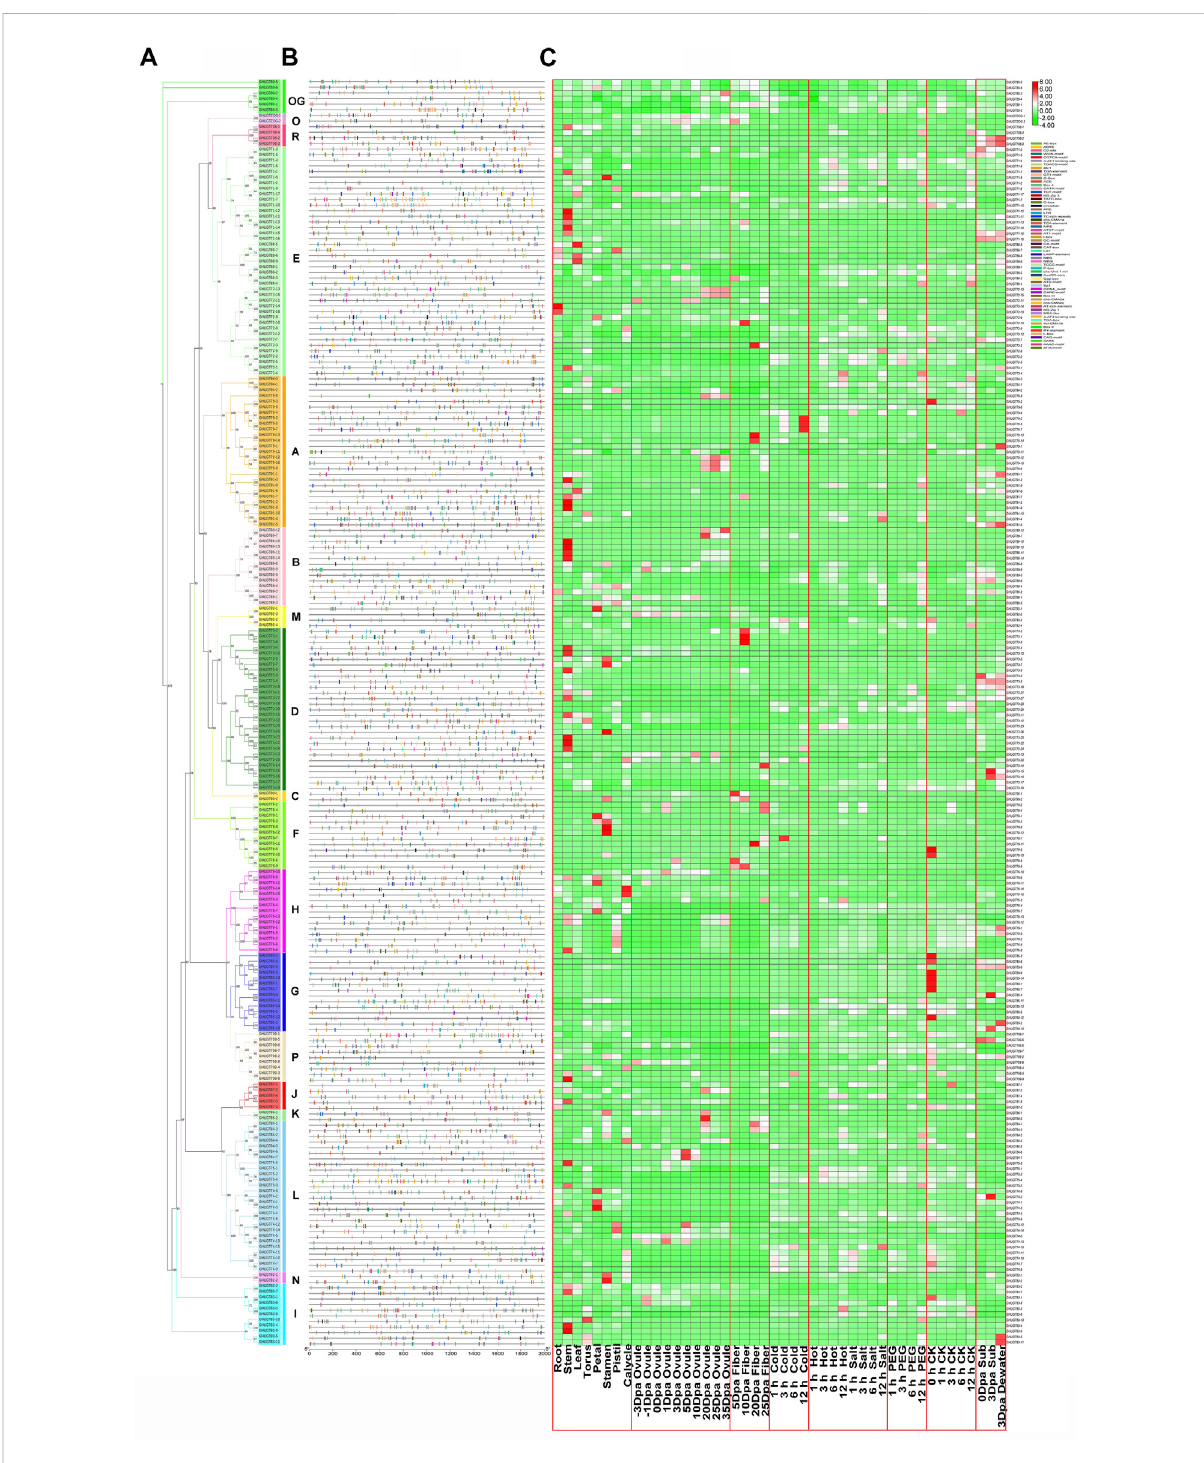
FIGURE 10 Promotersanddifferentiallyexpressedgeneanalysisofthe GHUGT family. (A) Phylogenetic treeof GHUGTs . (B) Cis-elements inthepromoters of GHUGTs . (C) Differentiallyexpressedgenesof GHUGTs undercold,hot,salt,PEGandsubmergencestressandtissue-speci fi cexpressionpatterns. The change from green to red represents the change in gene expression level from low to